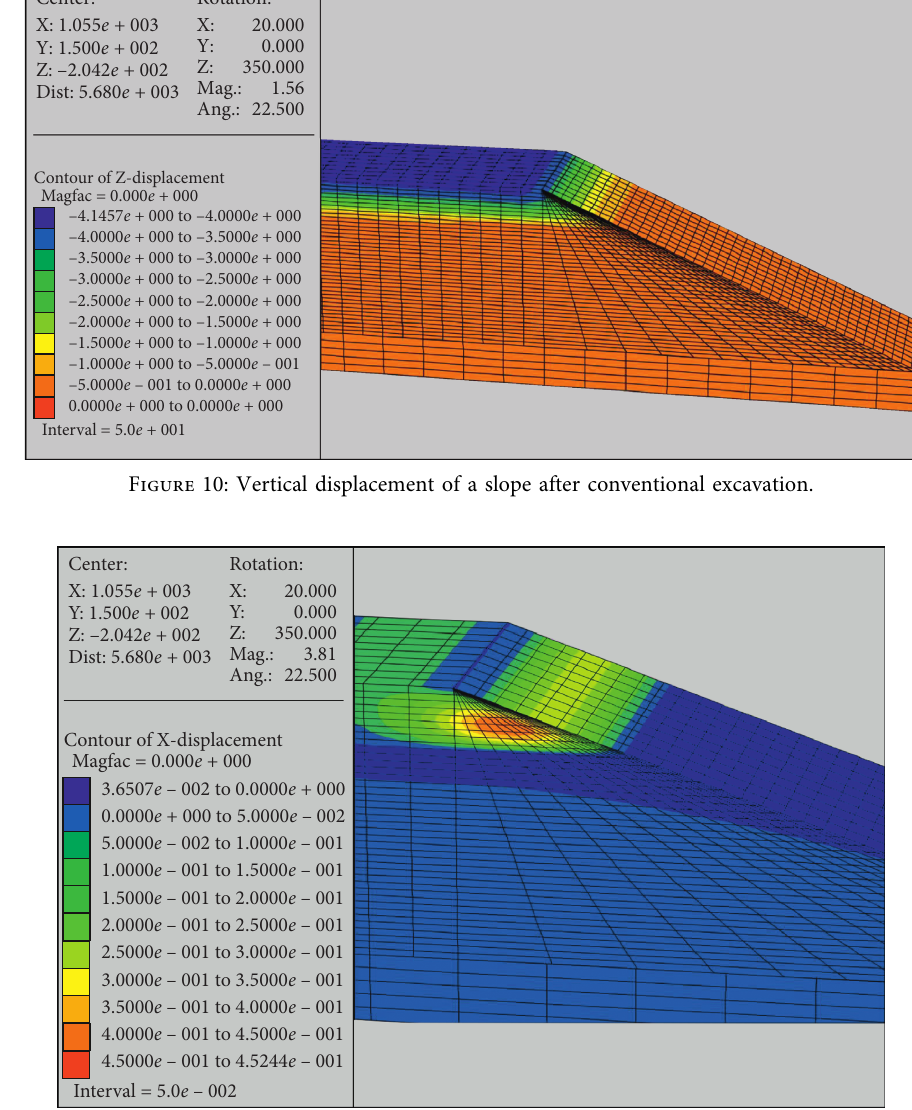
Figure 11: Horizontal displacement of a slope after conventional